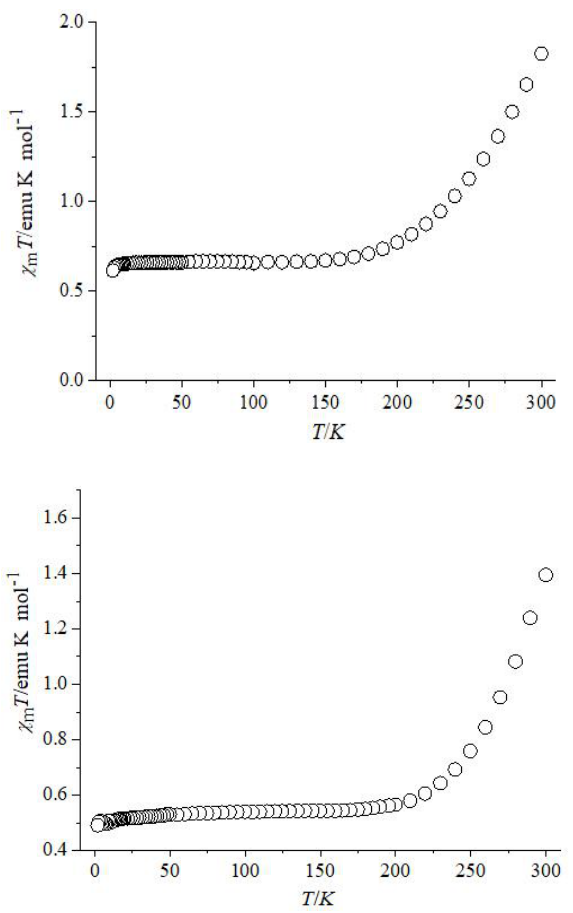
Figure S1. Temperature dependences of χ m T of 4 (top) and 5